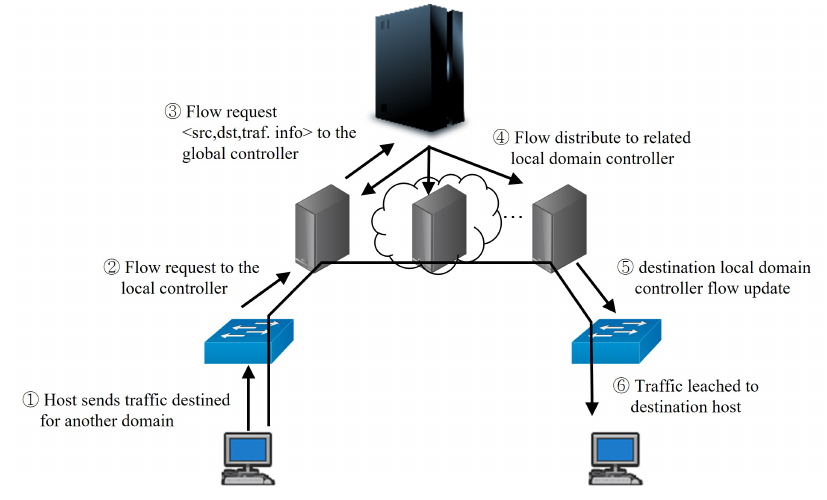
Figure 5. Path selection procedure for inter-domain